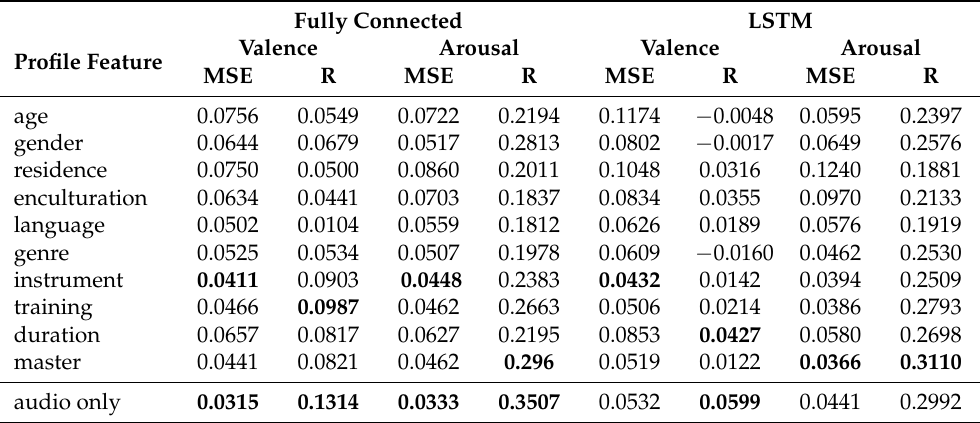
Table 6. Model performance when using both audio features as well as one profile feature as input. The best performing model is indicated in